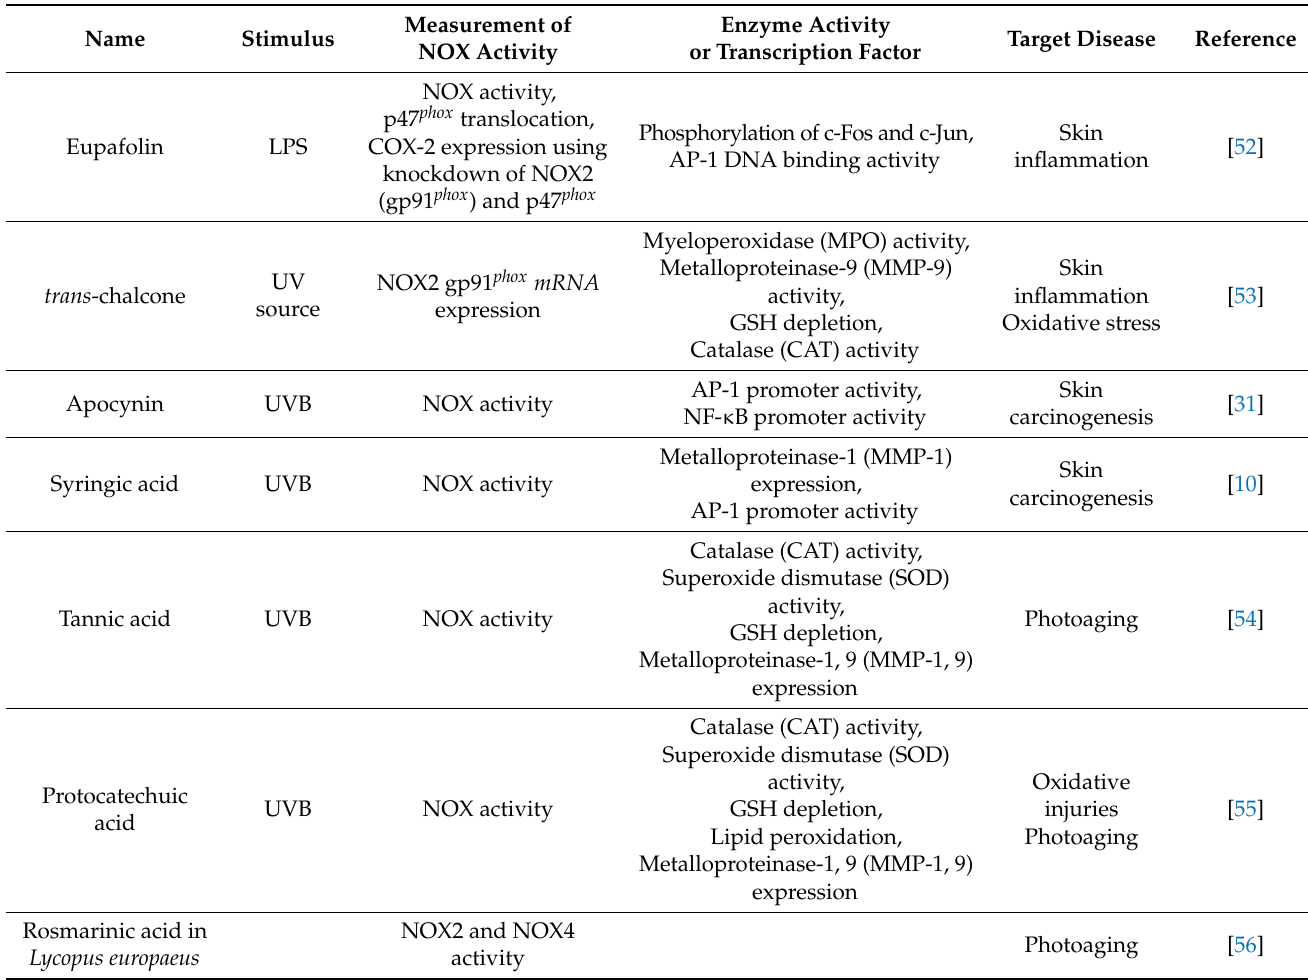
Table 1. Phytochemicals and their effects on NOX inactivation, enzyme activity, and